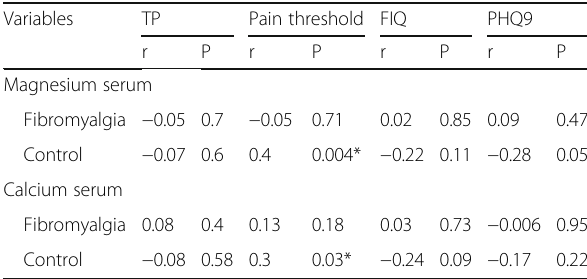
Table 3 Relationship between serum magnesium and calcium levels with the variables: pain, quality of life and risk of